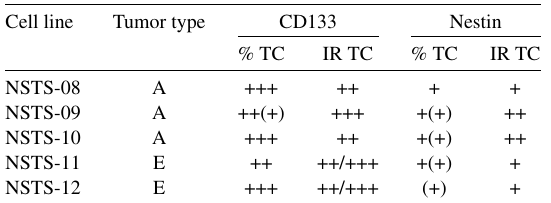
ExpressionofCD133andnestinintherhabdomyosarcomacelllines Cell line Tumor type CD133